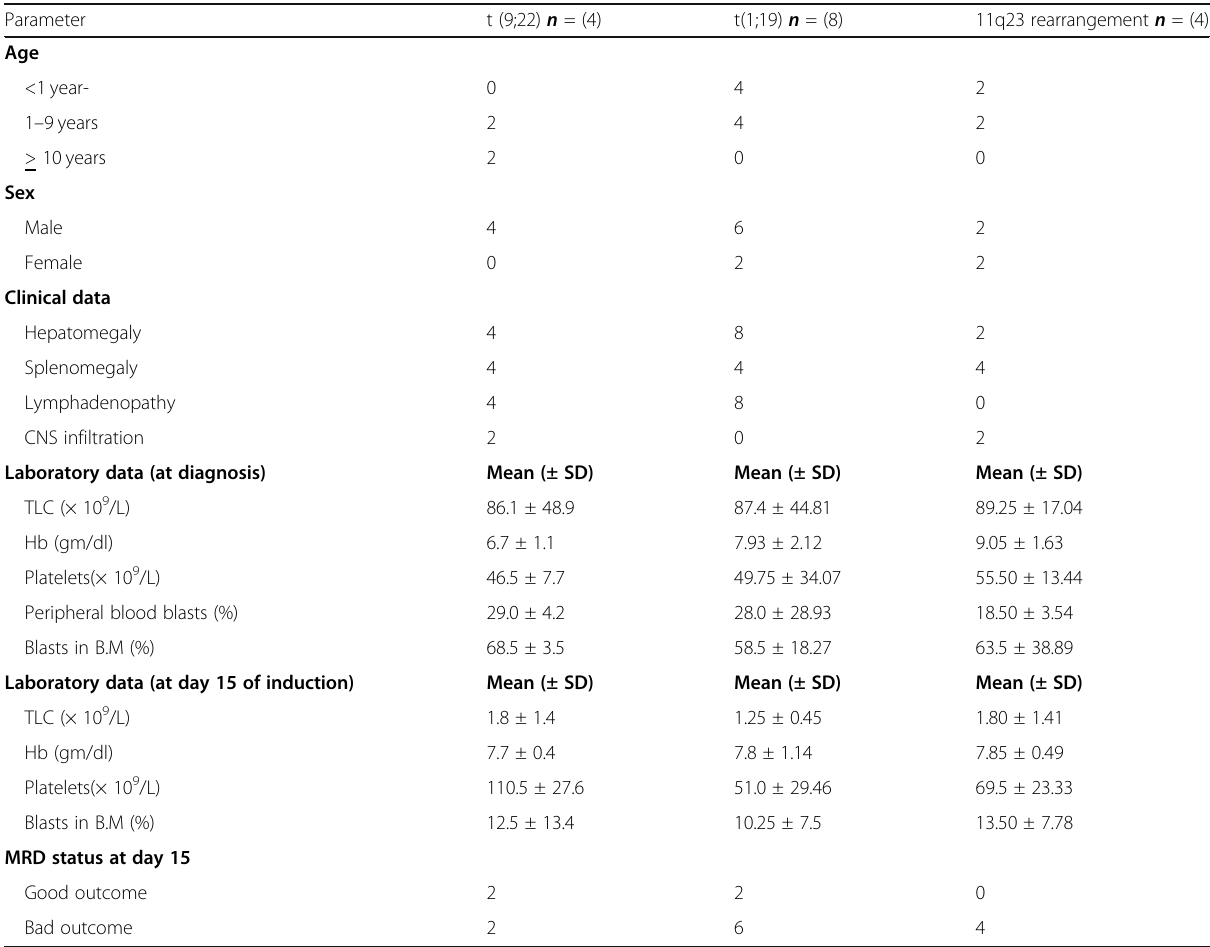
Table 2 Clinical and laboratory characteristics of the studied cytogenetic groups Parameter